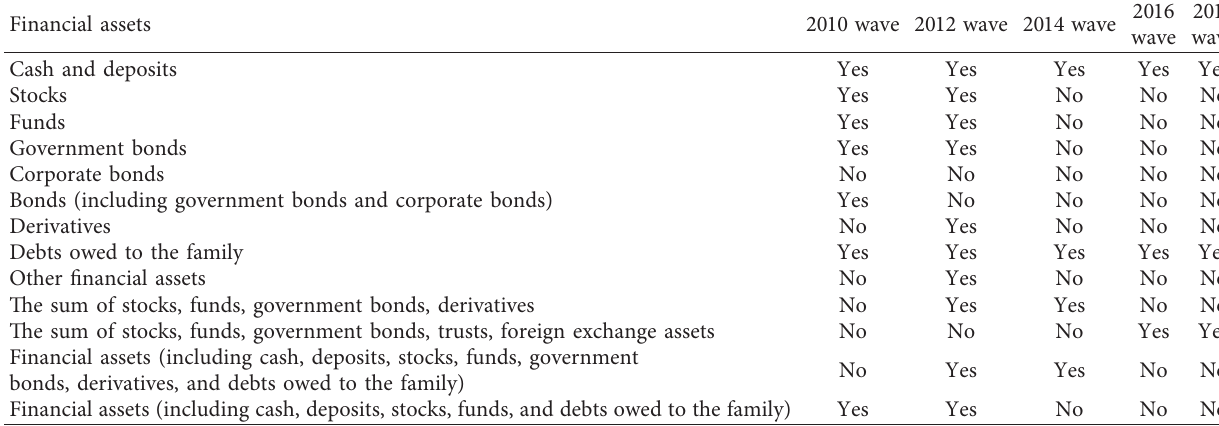
Table 1: Information on families’ financial assets in different waves of CFPS.